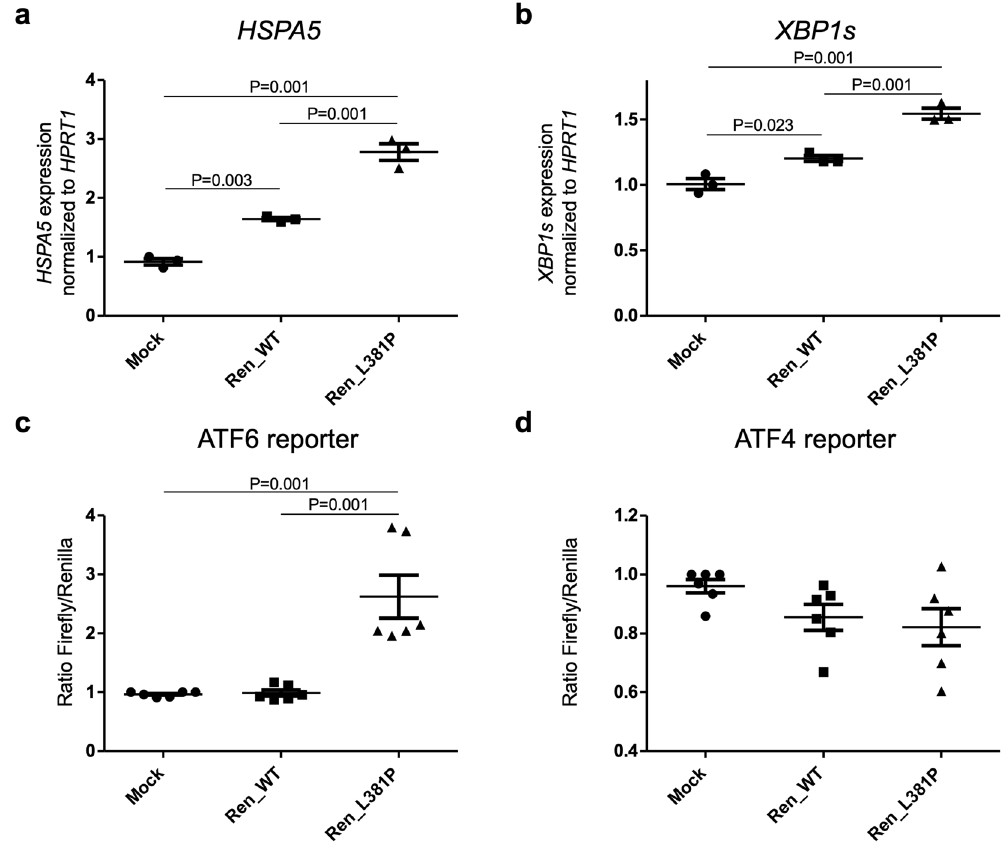
Figure 3. Expression of L381P renin isoform induces the UPR. (a) HSPA5 and ( b ) XBP1s expression analysis by real-time RT-qPCR. Gene expression is normalized to HPRT1 . Expression of L381P isoform in HEK cells induces expression of HSPA5 (BiP) and spliced XBP1 , markers of ER stress and UPR respectively. Data are expressed as mean ± s.d. (n = 3 independent experiments) (one way ANOVA, P = 1.78 × 10 − 5 and P = 1 × 10 − 4 for HSPA5 and spliced XBP1 respectively, followed by Tukey Honest Significant Difference (HSD) post hoc test). (c) ATF6 activation assessed through the use of a luciferase-based, ATF6 reporter construct. ATF6